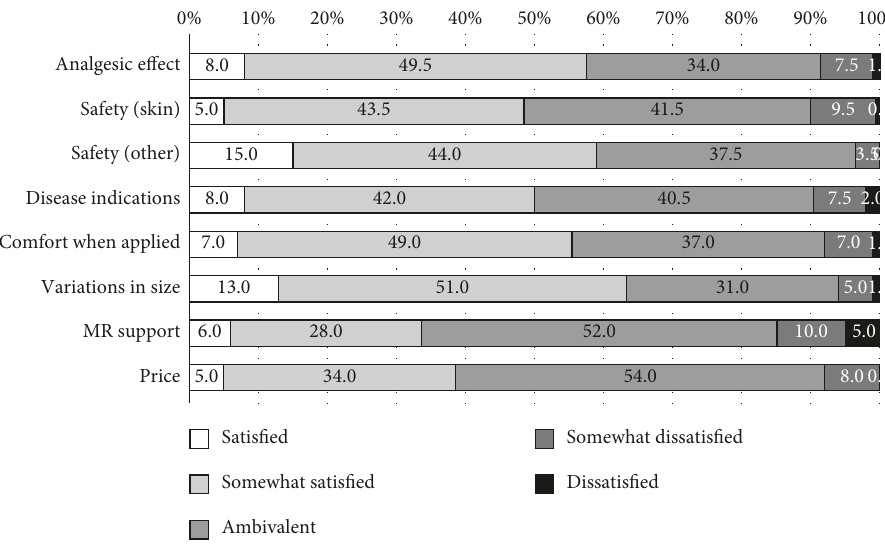
Figure 4: Physician survey: item-by-item satisfaction with NSAID plasters. Satisfaction of estimated analgesic effect, variation in size, and systemic safety were high. Satisfaction of MR support and price was low, but the majority of physicians were ambivalent to these factors. MR: medical representative.